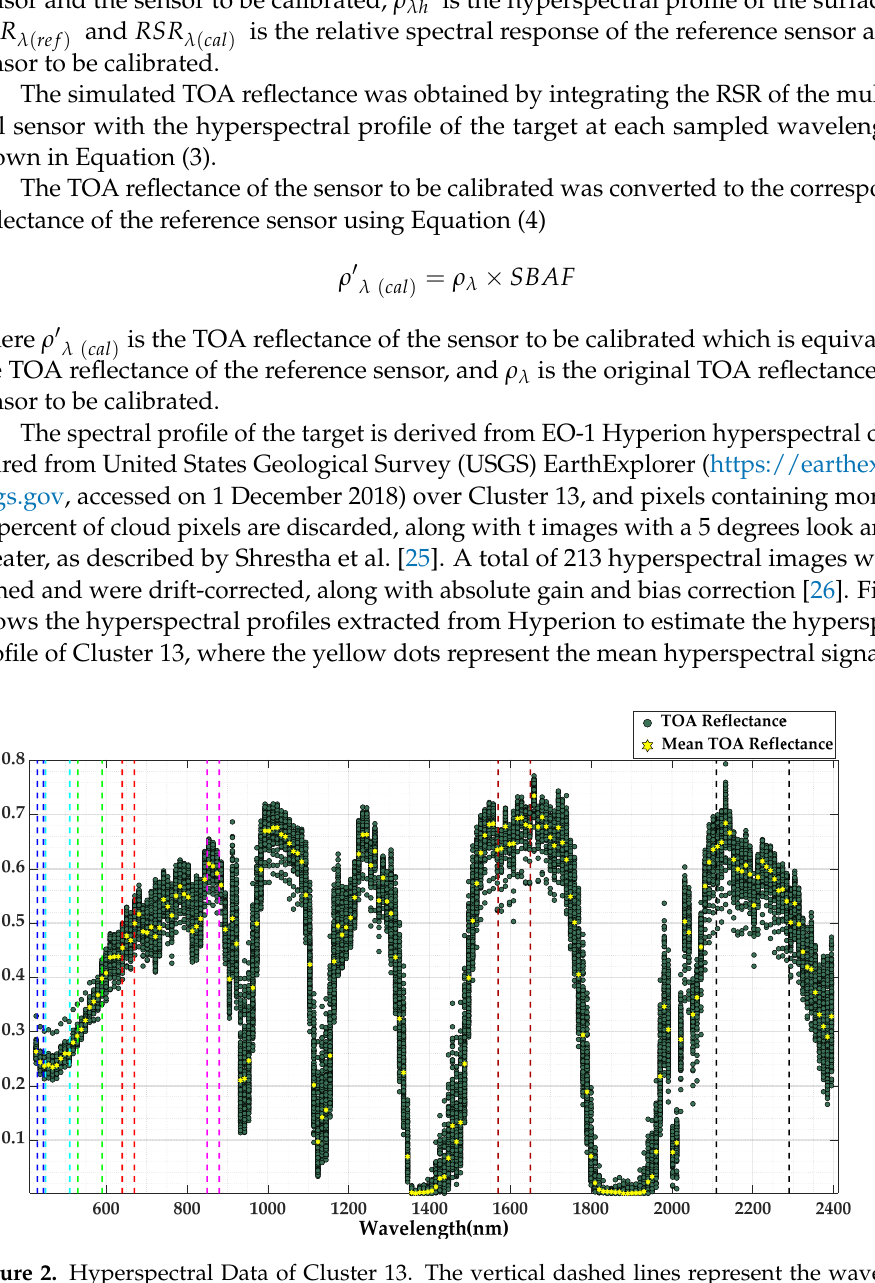
Figure 2. Hyperspectral Data of Cluster 13. The vertical dashed lines represent the wavelength ranges of Coastal Aerosol, Blue, Green, Red, NIR, SWIR 1, and SWIR 2bands. The SBAF corrected data were further normalized using the 15 coefficients quadratic model derived from four angles, which were also used to normalize the TOA reflectance of all the sensors, as described in the next section.